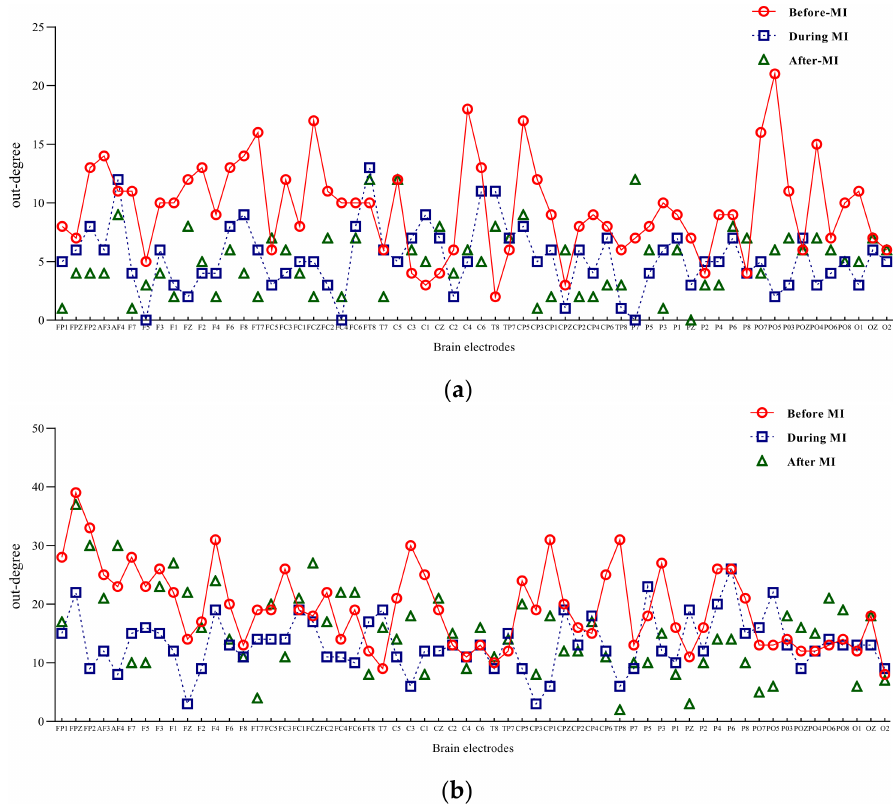
Figure 5. Mu/beta out degree of three different states of motor imagery. ( a ) Mu-rhythm out degree of three different states of motor imagery. ( b ) Beta-rhythm out degree of three different states of motor